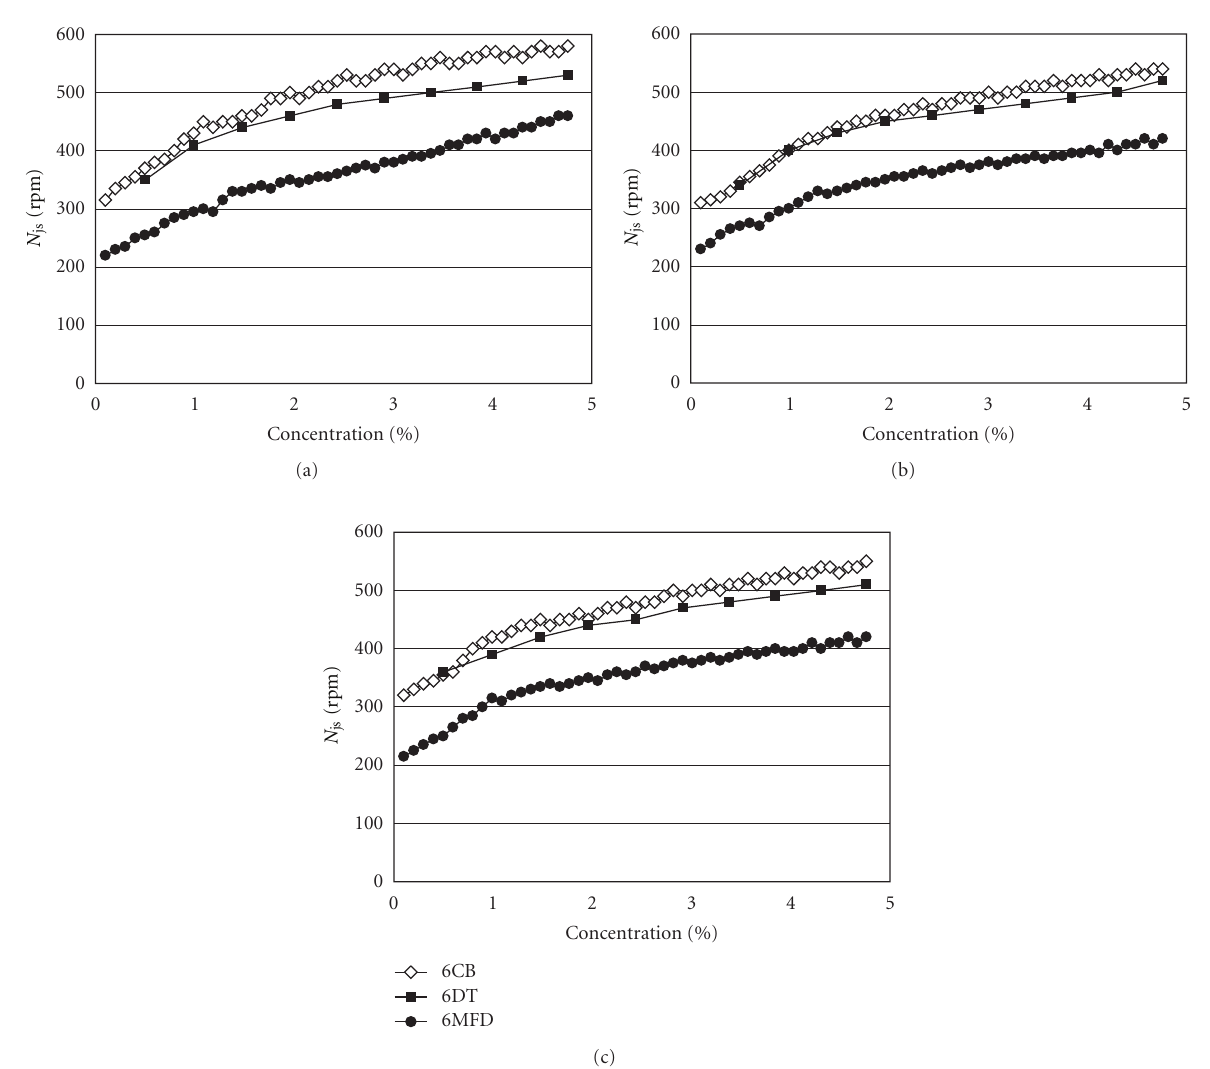
Figure 5: N js (rpm) versus concentration (%), at varying impeller geometries. (a) size of activated carbon: 1.40–2.36 mm, (b) size of activated carbon: 1.00–1.40 mm, (c) size of activated carbon: 0.75–1.00